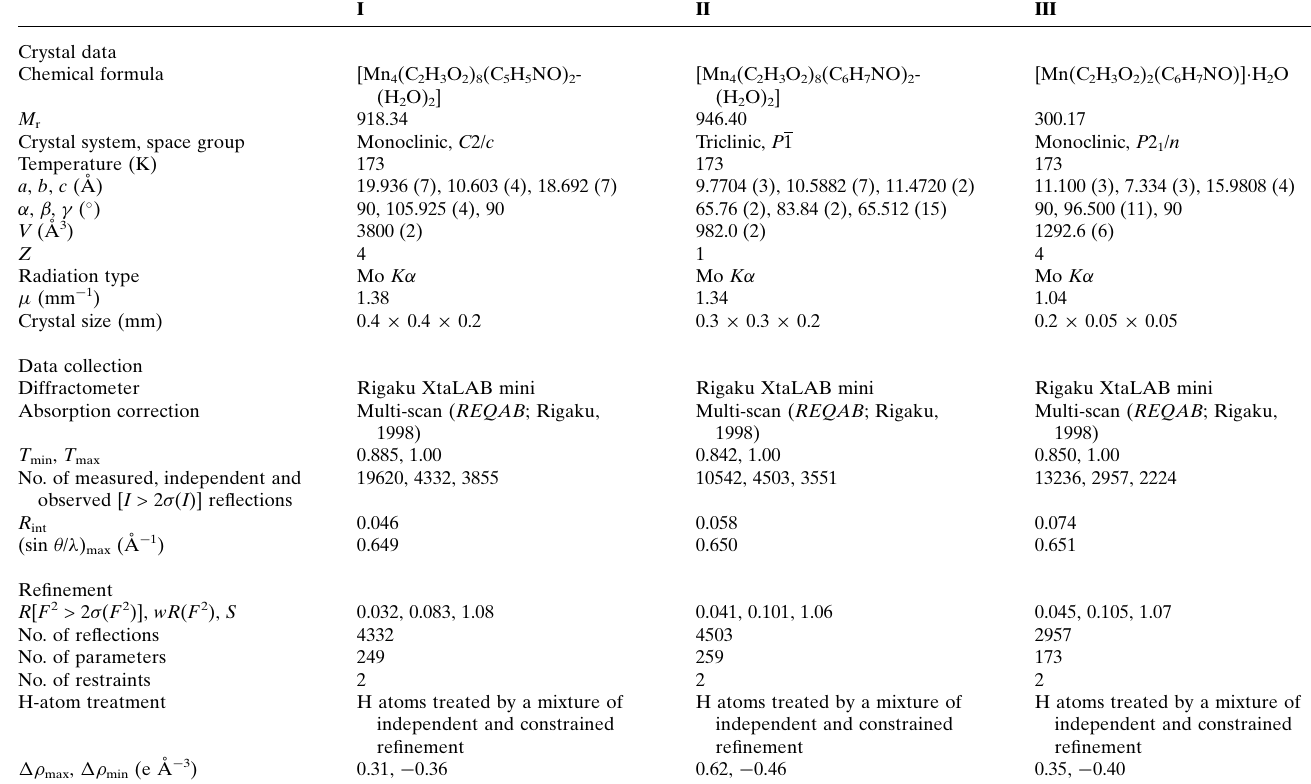
Table 4 Experimental details.